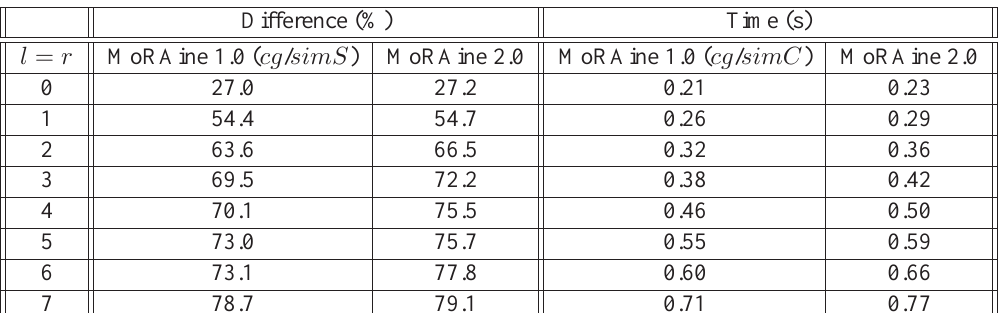
Difference (%) Time (s)